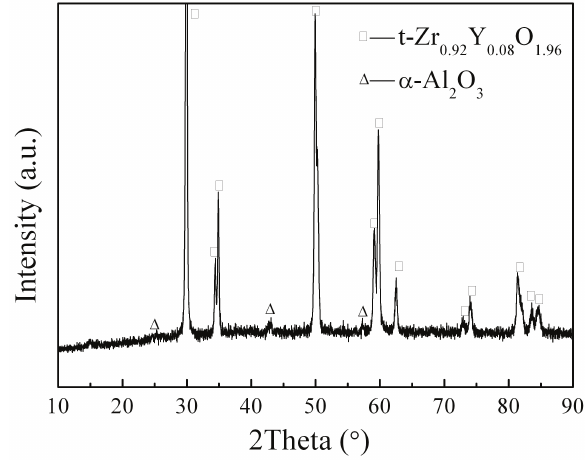
Figure 2. XRD spectrum of fiber-reinforced TBCs with micro-laminated ZrO 2 /Al 2 O 3